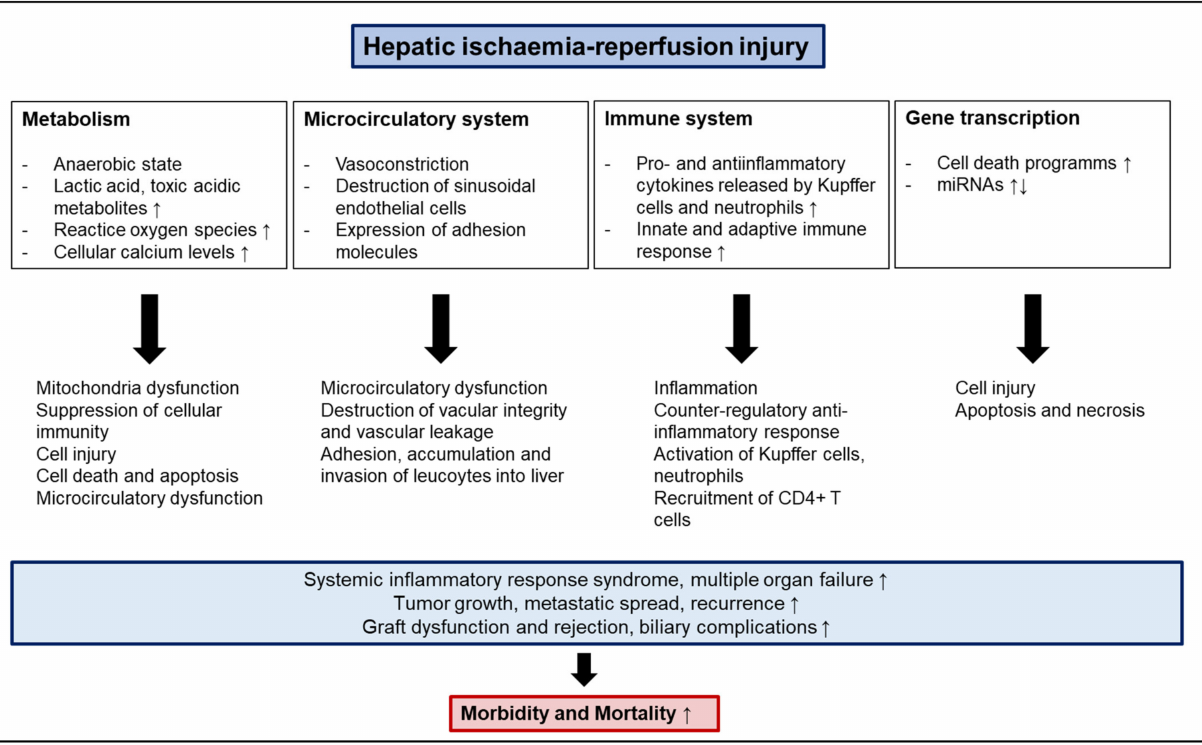
Figure 1. Components of hepatic ischemia reperfusion